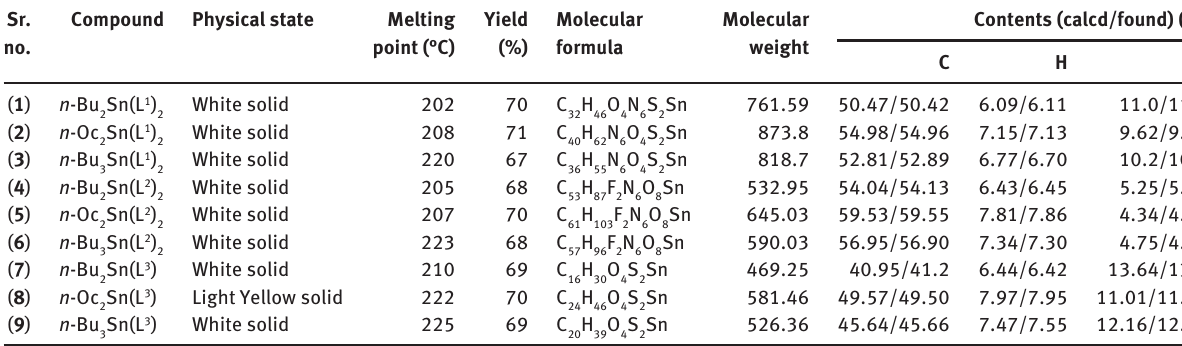
Table 1 Elemental analysis and some physical properties of organotin(IV) complexes. Sr.